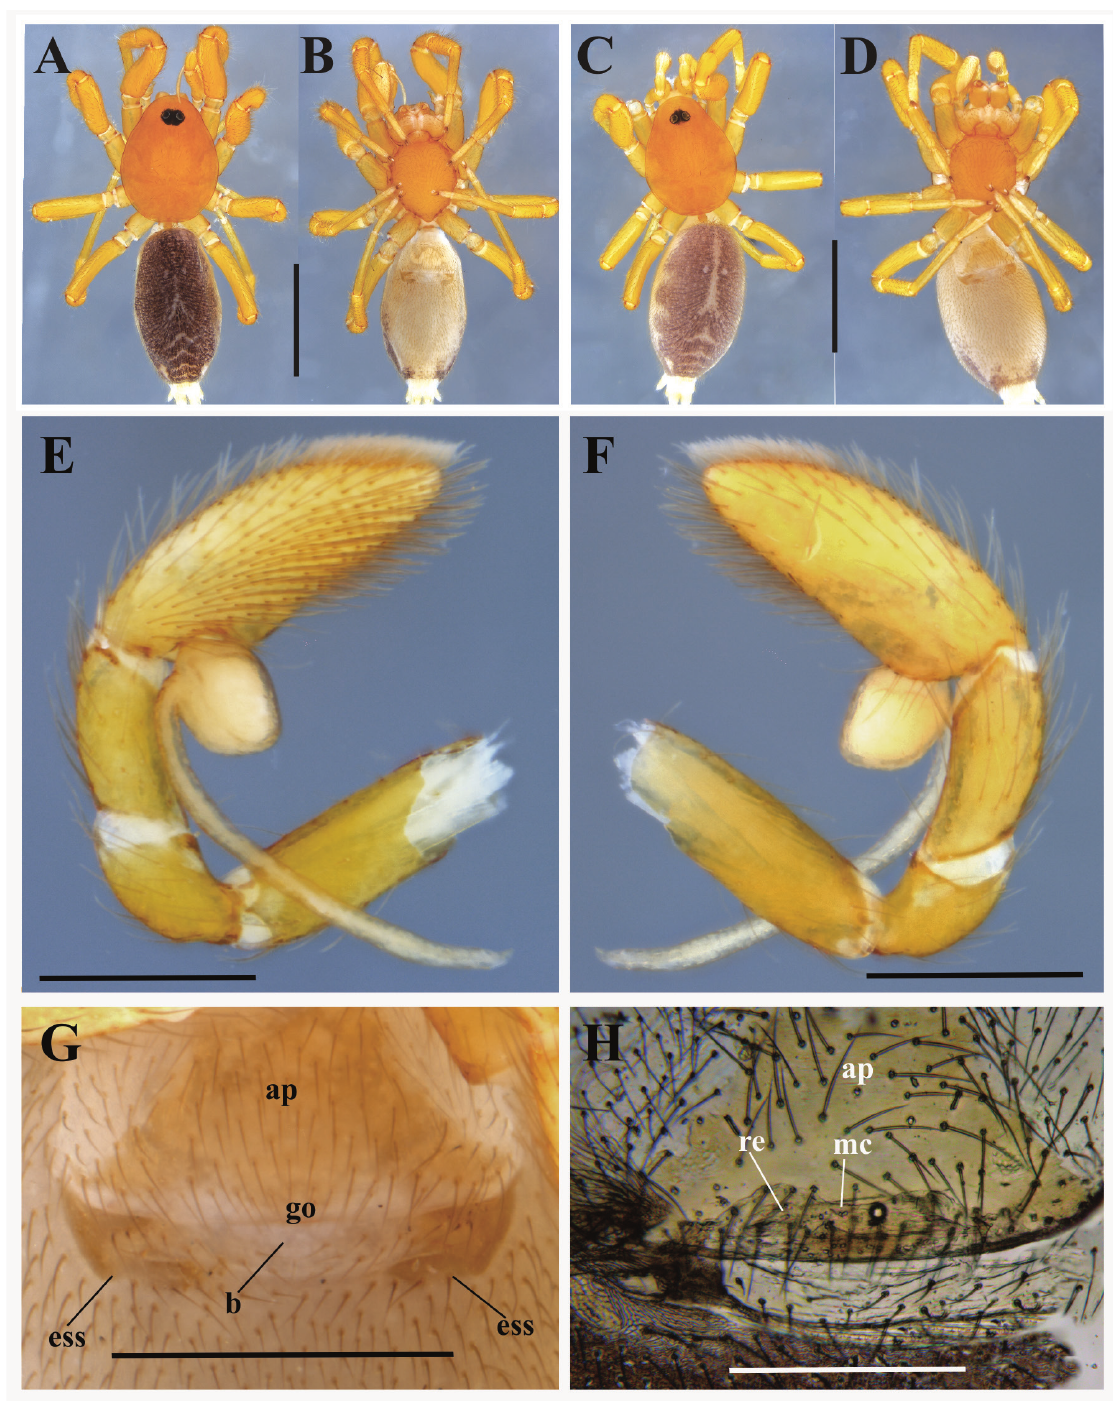
Fig. 4. Medionops luiscarlosi sp. nov. A–B, E–F . Holotype, ♂ (IAvH-I 3361). C–D, G–H . Paratype, ♀ (IAvH-I 3772). A . Habitus, dorsal view. B . Habitus, ventral view. C . Habitus, dorsal view. D . Habitus, ventral view. E . Left palp, retrolateral view. F . Left palp, prolateral view. G . External genitalia, ventral view. H . Internal genitalia, dorsal view. Scale bars: A–D = 1.5 mm; E–F = 0.7 mm; G = 0.5 mm; H = 0.2 mm. Abbreviations: p = anterior plate; b = area below genital opening; ess = external sclerotization around spiracles; go = genital opening; re = receptaculum; mc = median